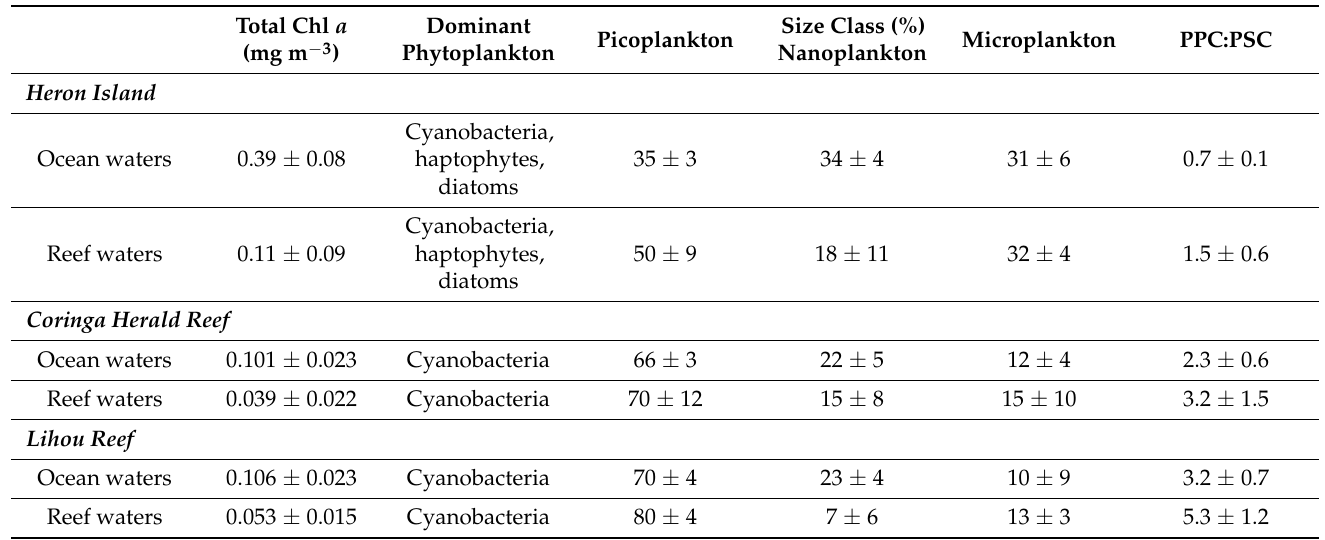
Table 3. The average values for the phytoplankton associated variables measured at the three sites. The dominant phytoplankton group was determined from the pigment composition